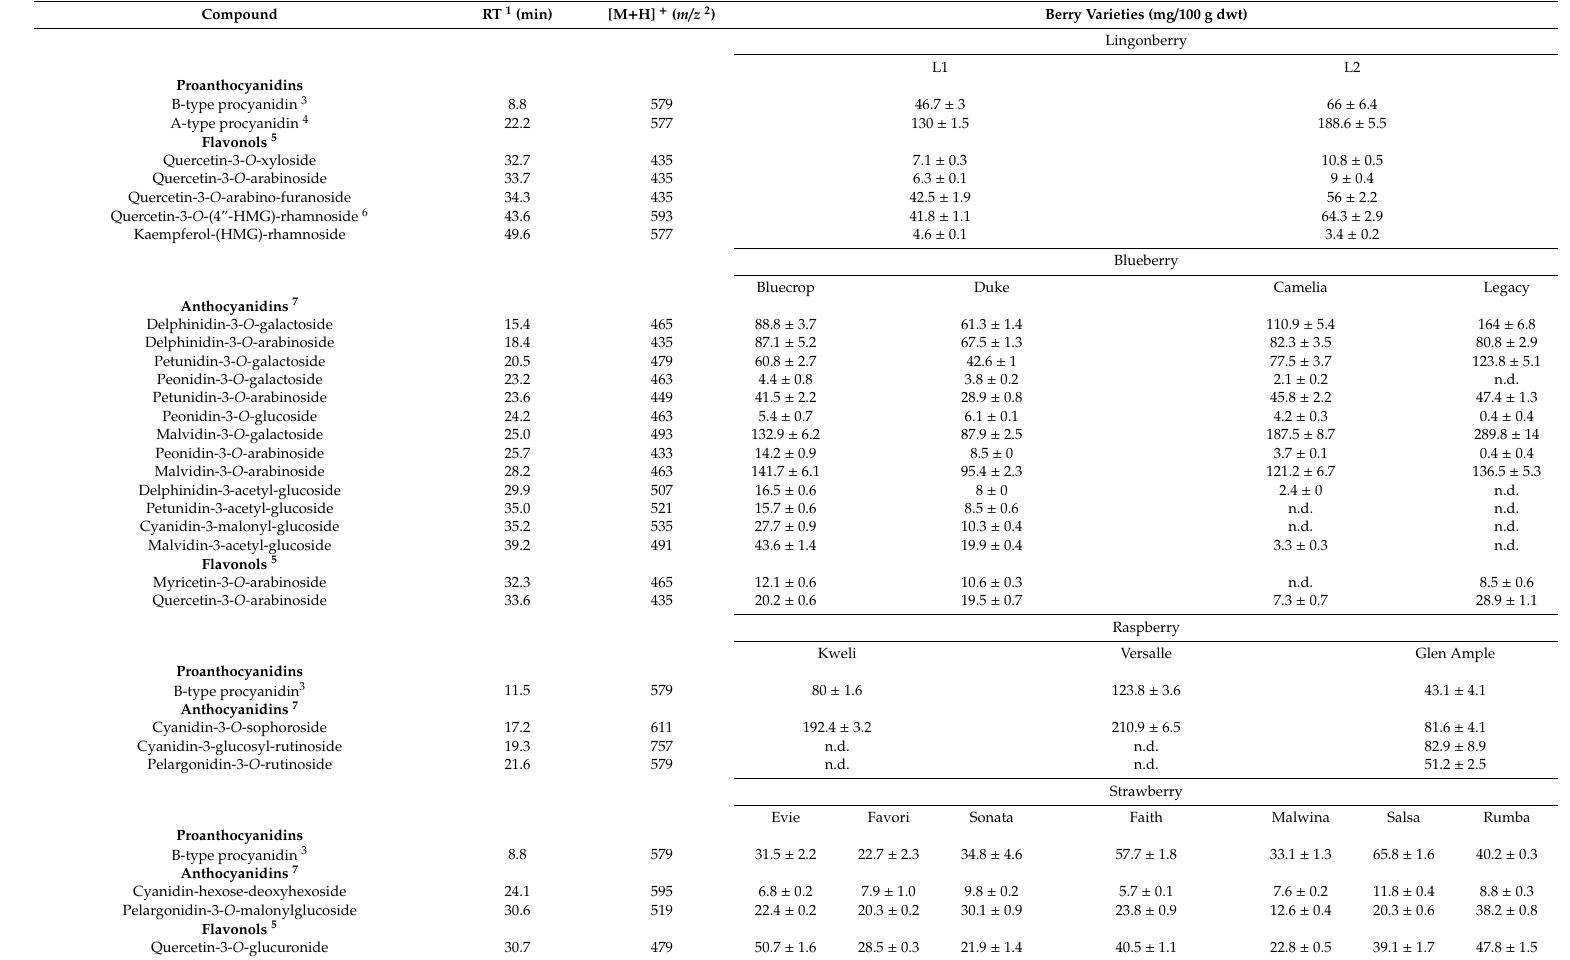
Table 3. Content (mg / 100 g dwt) of tentatively identified flavonoids in all